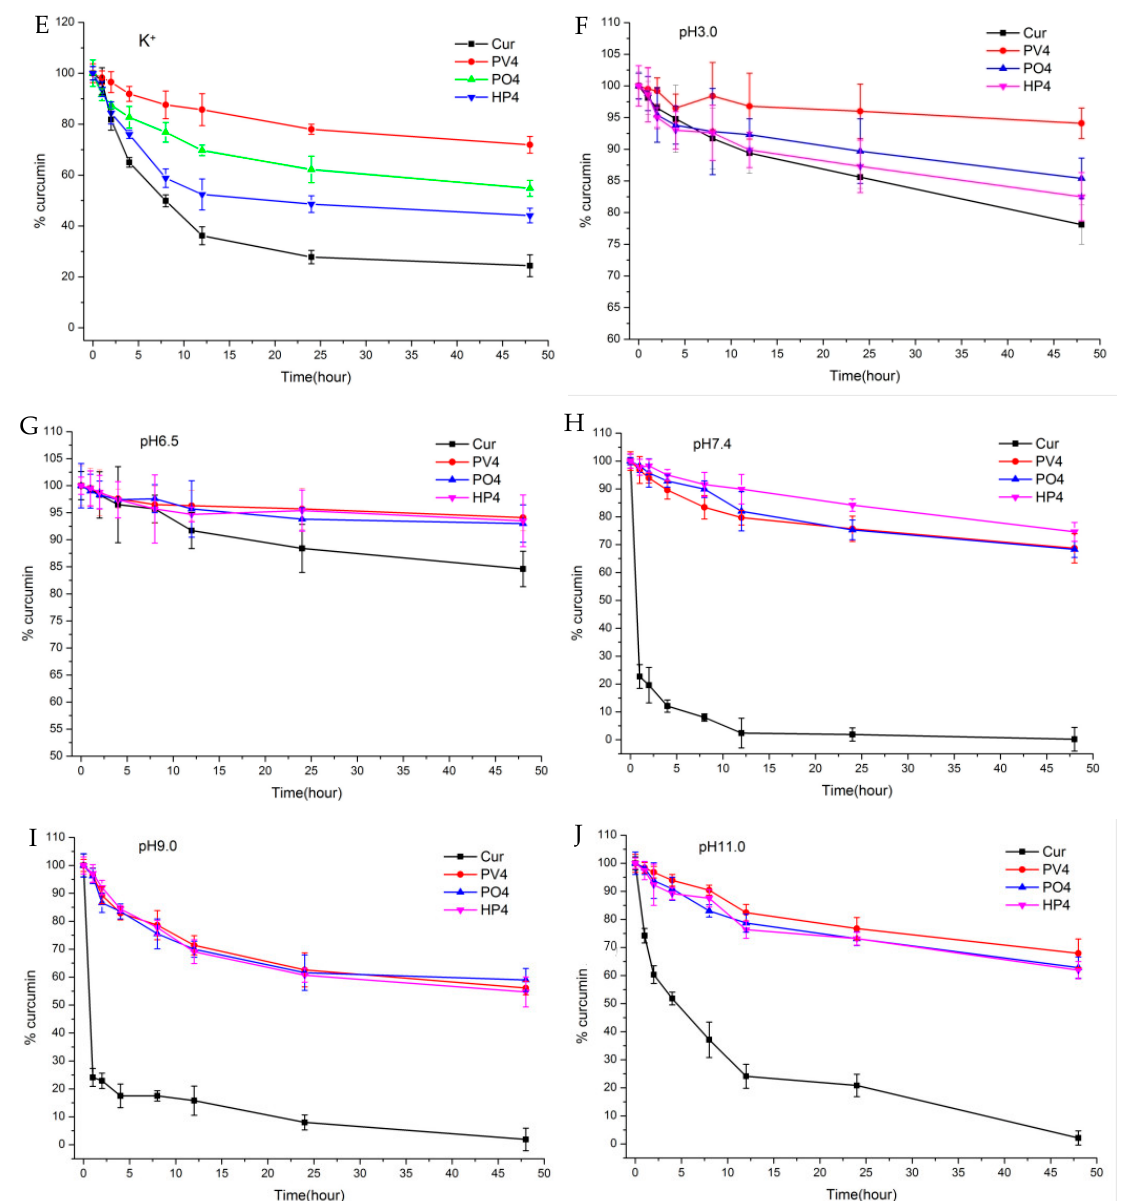
Figure 4. ( A – E ) The stability of Curcumin and Curcumin solid dispersion in metal ions solution and ( F – J ) phosphate buffer solutions of different pH values.